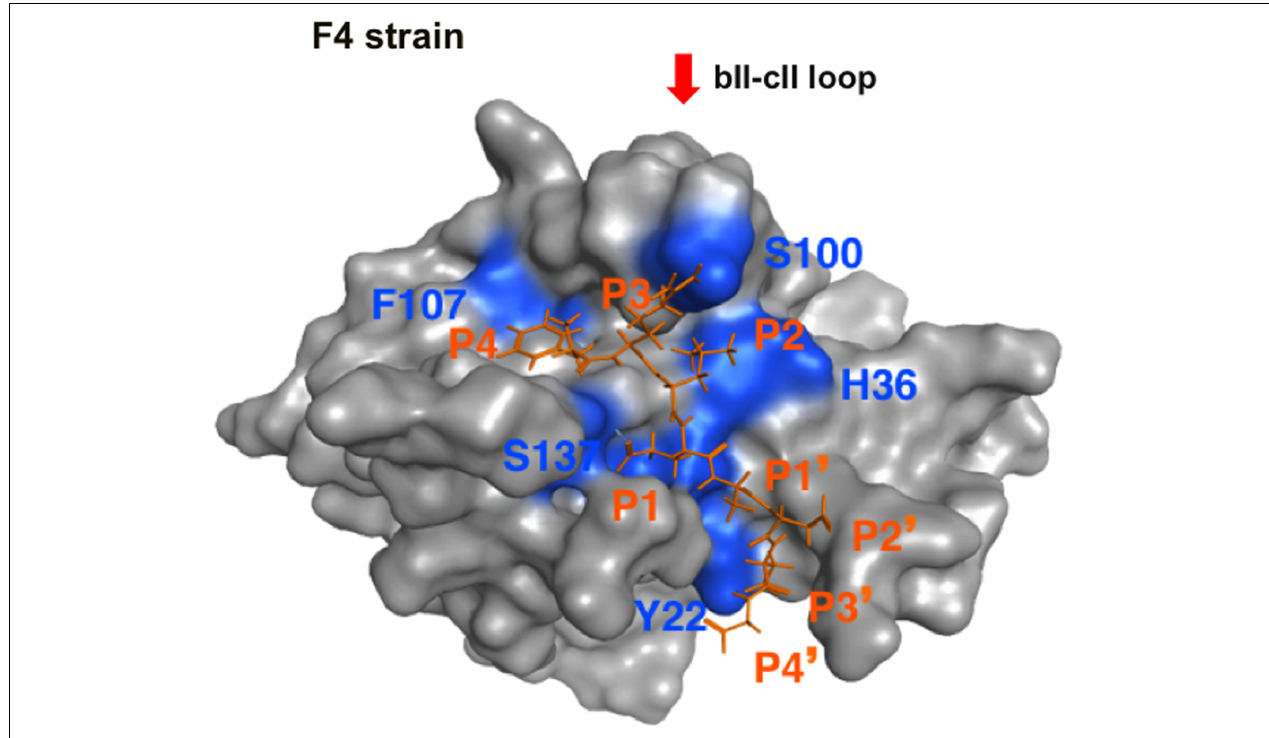
FIGURE 6 | MD simulation of the protease-substrate complex model. The molecular model of the FCV F4 strain protease-substrate complex was subjected to MD simulation using modules in the AMBER program package (Case et al., 2014) as described for MD simulations of the HIV-1/SIV envelope gp120 subunit (Naganawa et al., 2008; Yokoyama et al., 2012a, 2016; Kuwata et al., 2013; Hikichi et al., 2016). After heating calculations for 20 ps until 310 K using the NVT ensemble for the constant volume, temperature, and numbers of particles in the system, simulation was executed using the NPT ensemble for the constant pressure, temperature, and numbers of particles in the system at 1 atm, at 310 K, and in 150 mM NaCl for 30 ns. The protease was restrained using a harmonic potential with a graded decreasing force constant from 10 to 1 kcal/mol/Å 2 . A structure at 30 ns of simulation is shown. A red arrow indicates the bII-cII loop (Fernandes et al., 2015) near the substrate binding site. The substrate octapeptide (FCV F4-6) is shown using an orange stick model.